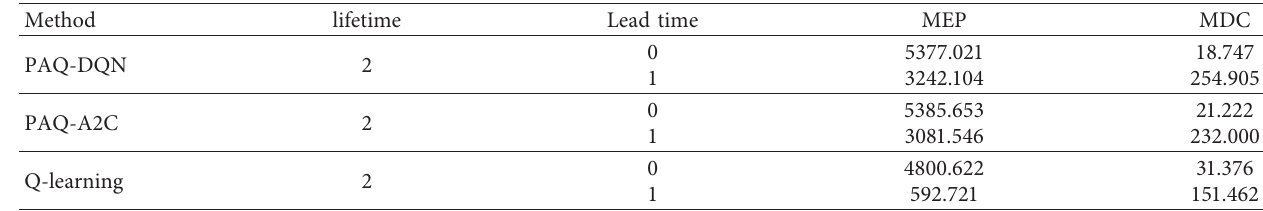
Table 4: Results.